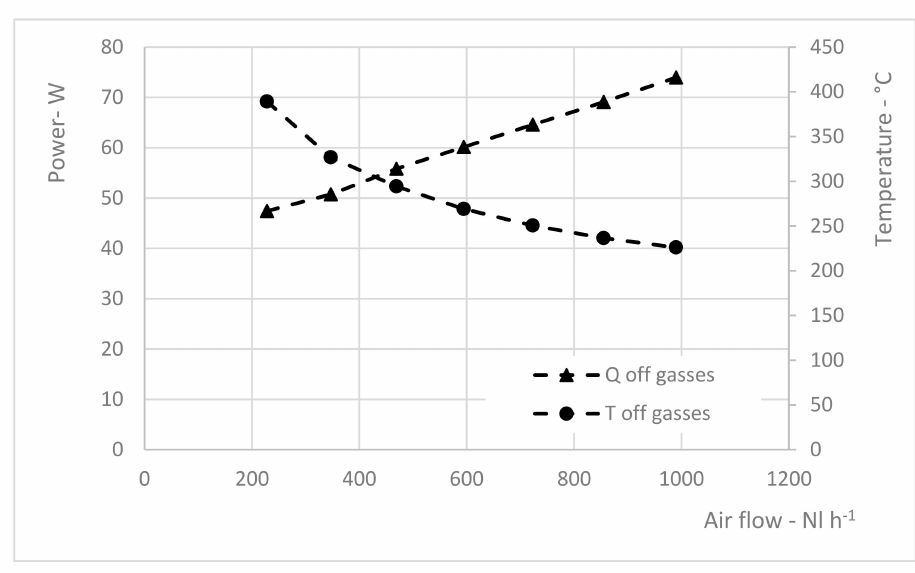
Figure 10. Temperature and heat available in off gasses as function of air